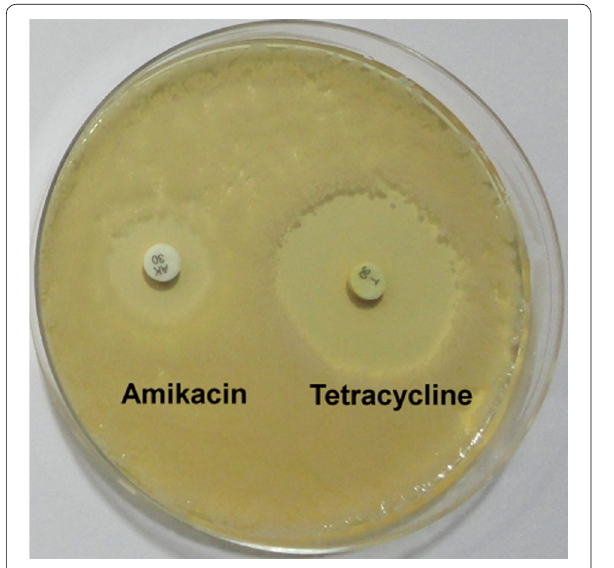
Table 2 Time-dependent selenium removal (%) by